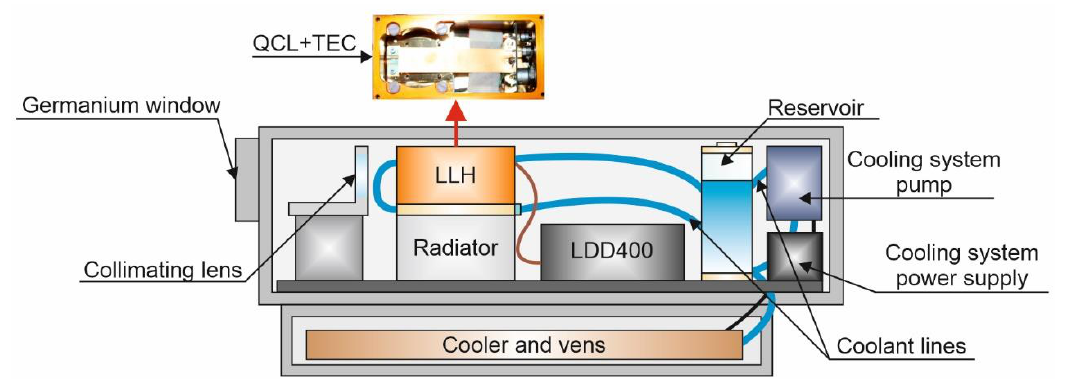
Figure 3. A diagram of the free space optics communication (FSO) system transmitter module.